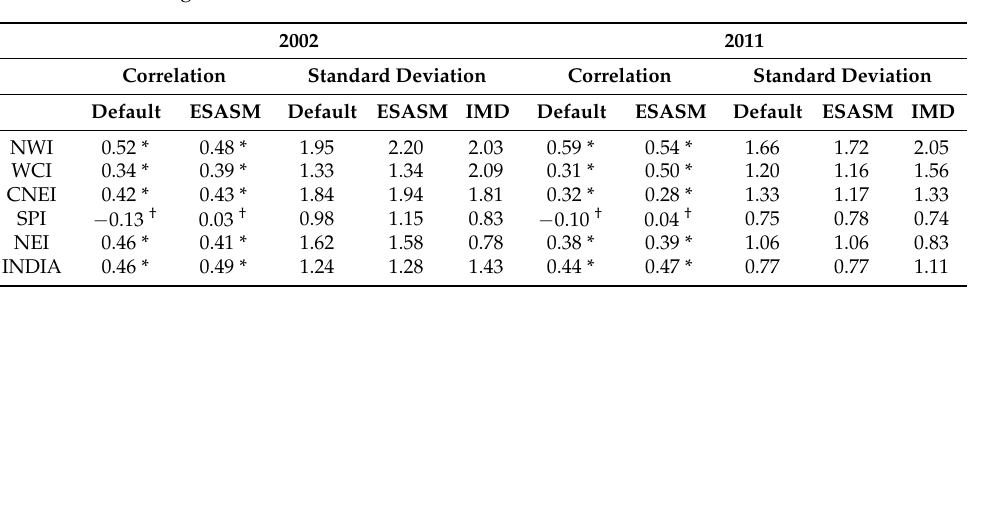
Table 2. Temporal statistics of surface temperature ( ◦ C) from default, ESA configuration and IMD data over the whole of India and five homogeneous regions for the years 2002 and 2011. *: significant at 95% and †: not significant at